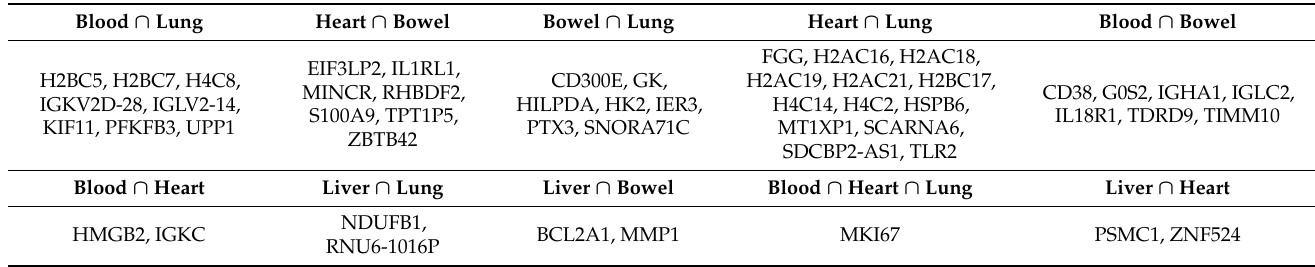
Table 1. Differentially expressed genes common across tissues and their